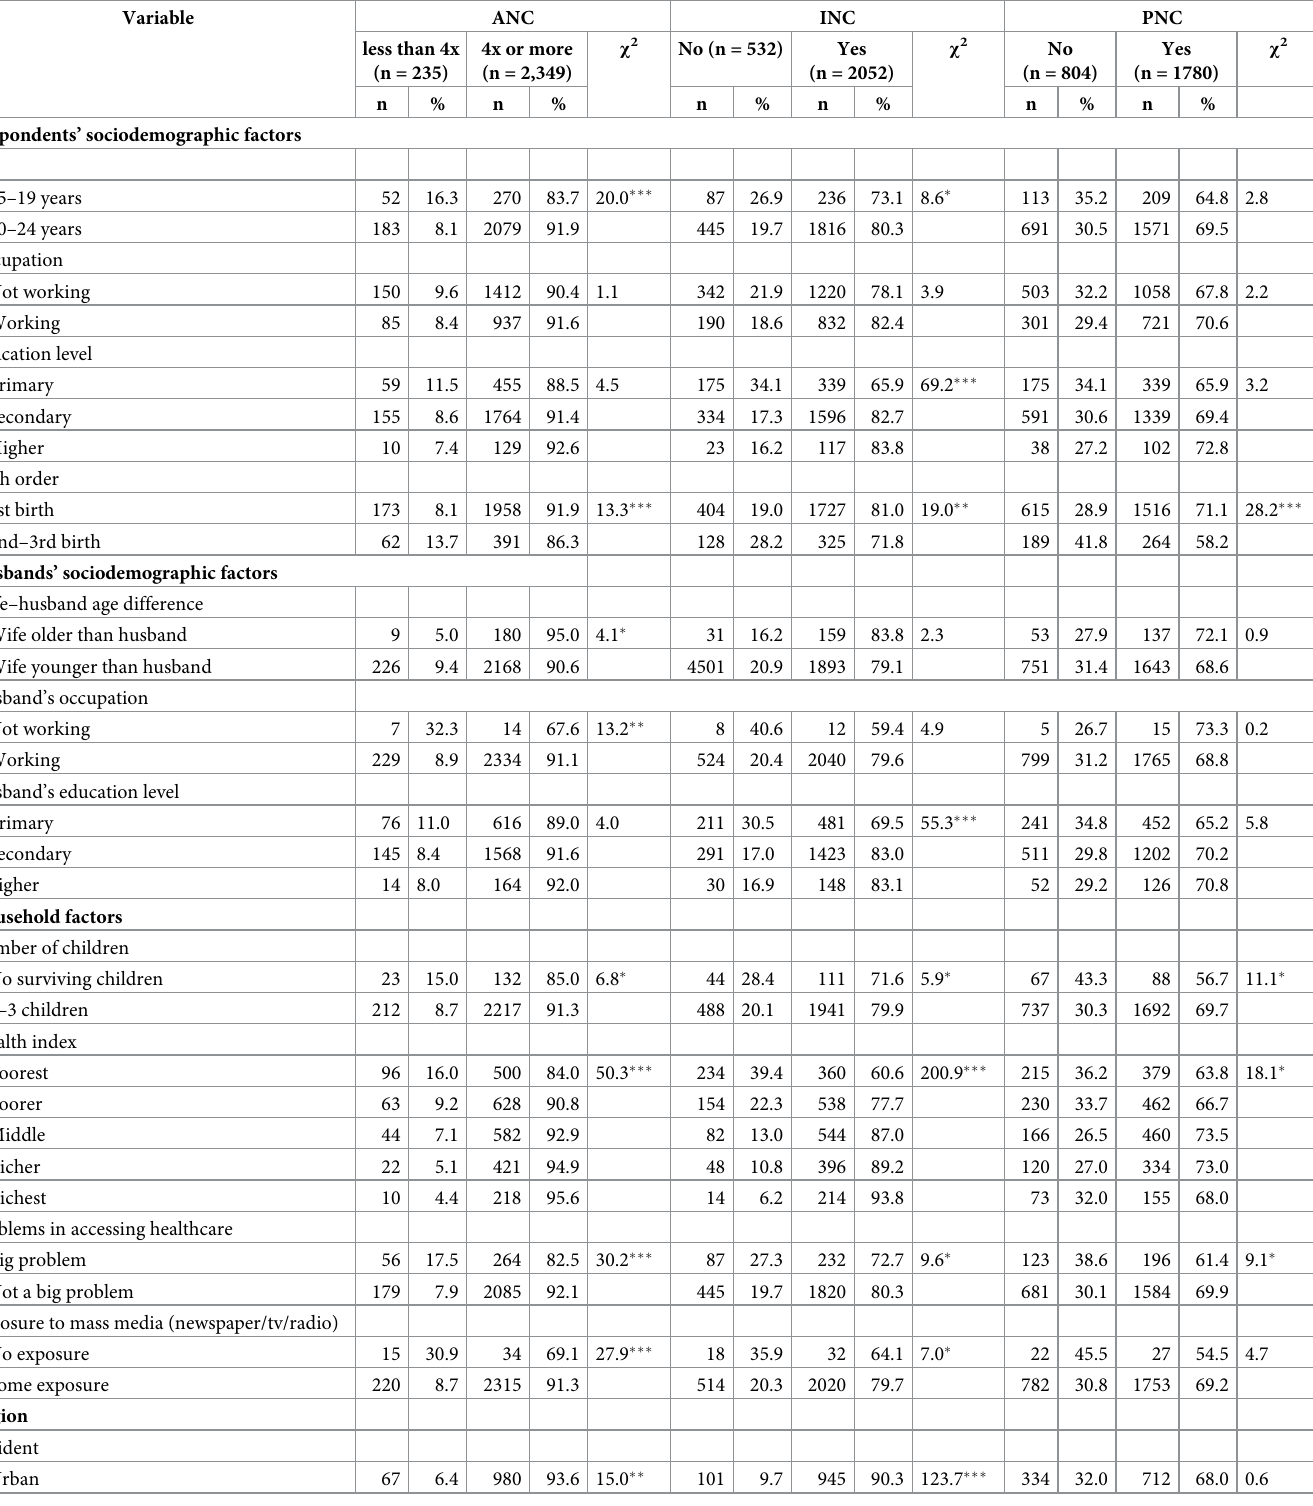
Table 2. Bivariate analysis of ANC, INC, and PNC utilization among mothers aged 15–24 years in Indonesia.